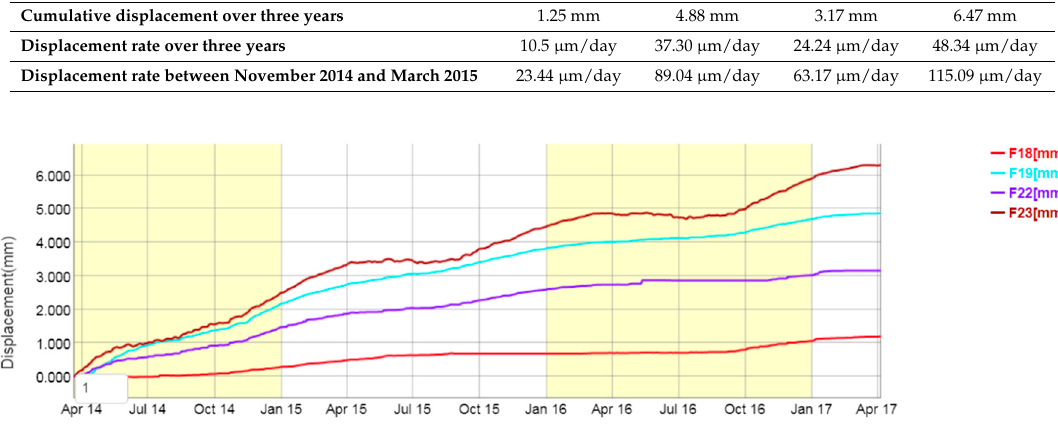
Figure 10. Displacements recorded by the internal segments crackmeters in the three-year period—the graph has been produced directly through the web-based platform.